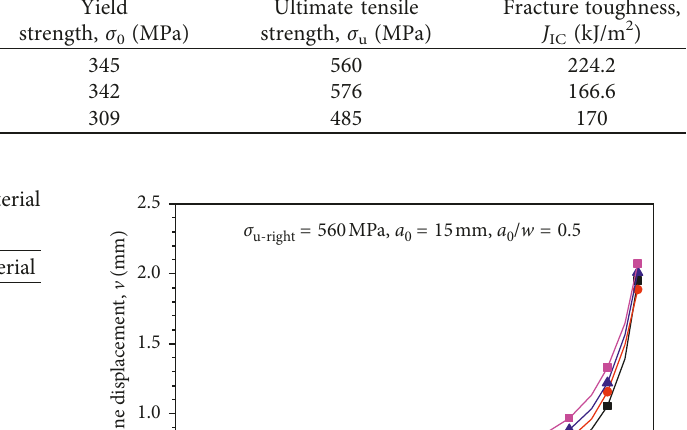
Table 1: Mechanical properties of materials used in DMW joints of RPV [25–27]. Material type